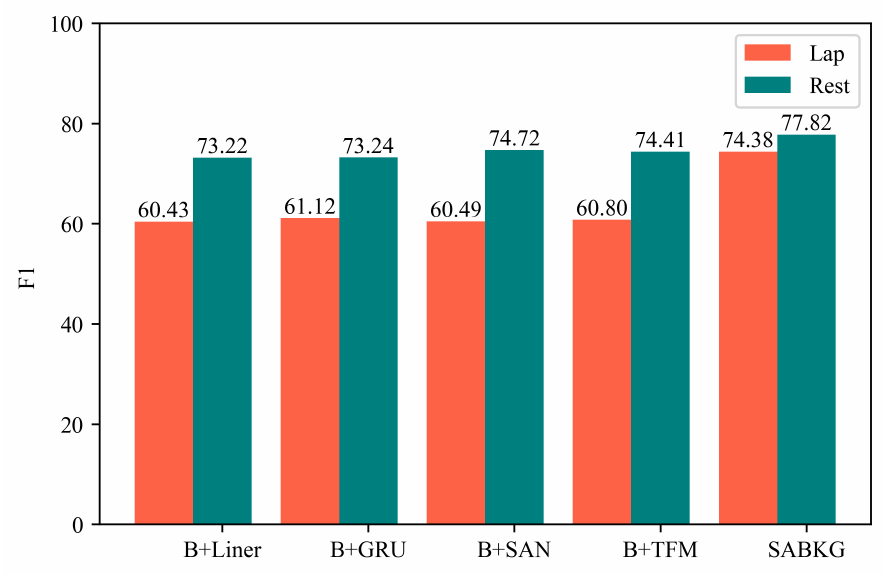
Figure 4. Comparison with BERT-BASED